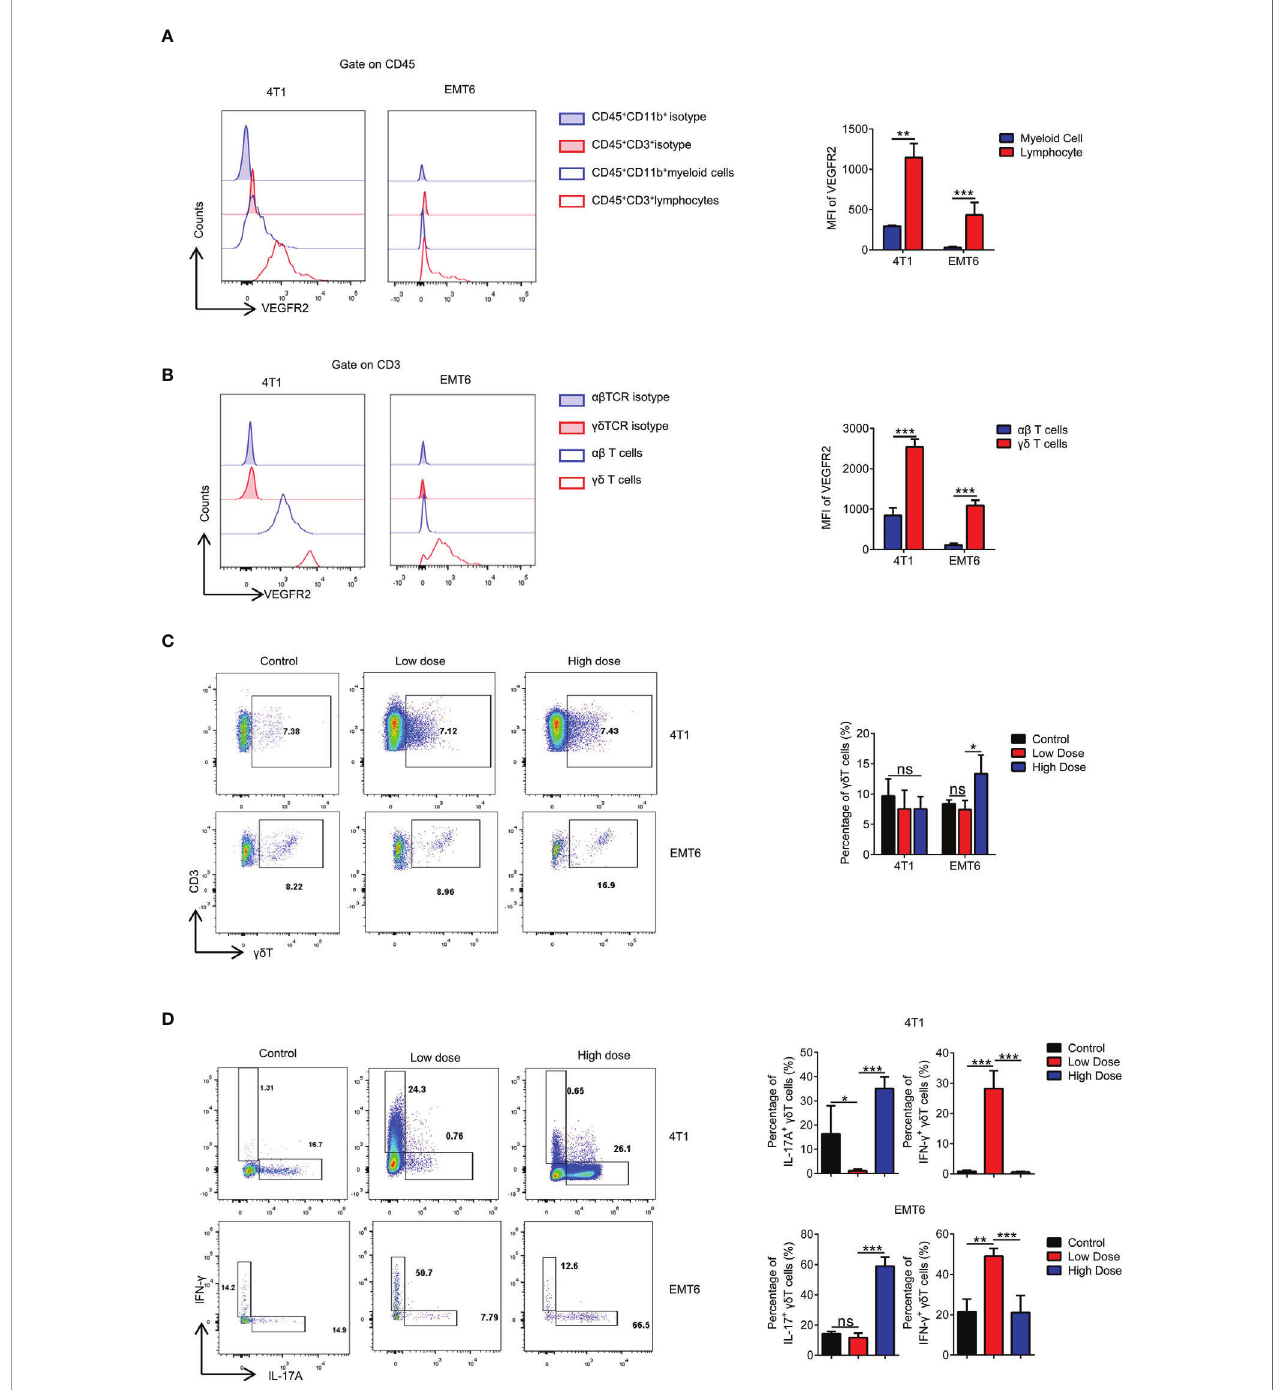
FIGURE 2 | High-dose VEGFR2-TKI therapy contributes to differentiation into IL17A-producing gd T cells rather than IFN- g producing gd T cells. (A) Flow cytometry analysis of VEGFR2 expression of myeloid cells (CD45 + CD11b + ) and lymphocytes (CD45 + CD3 + ). (B) Flow cytometry analysis of VEGFR2 expression of ab T cells (CD45 + CD3 + TCR b + ) and gd T cells (CD45 + CD3 + TCR gd + ). (C) Frequency of gd T cells in the tumor after anti-VEGFR2 therapy. (D) Intracellular IFN- g and IL17A expression of gd T cells from tumors in vivo . Data are presented as the means ± SD from one representative experiment. Similar results were obtained from three independent experiments, n=4 mice each group, unless indicated otherwise. Statistical analysis was performed by two-tailed unpaired Student ’ s t test. ns, not signi fi cant, *p < 0.05, **p < 0.01, and ***p < 0.001. See also Supplementary Figure S3